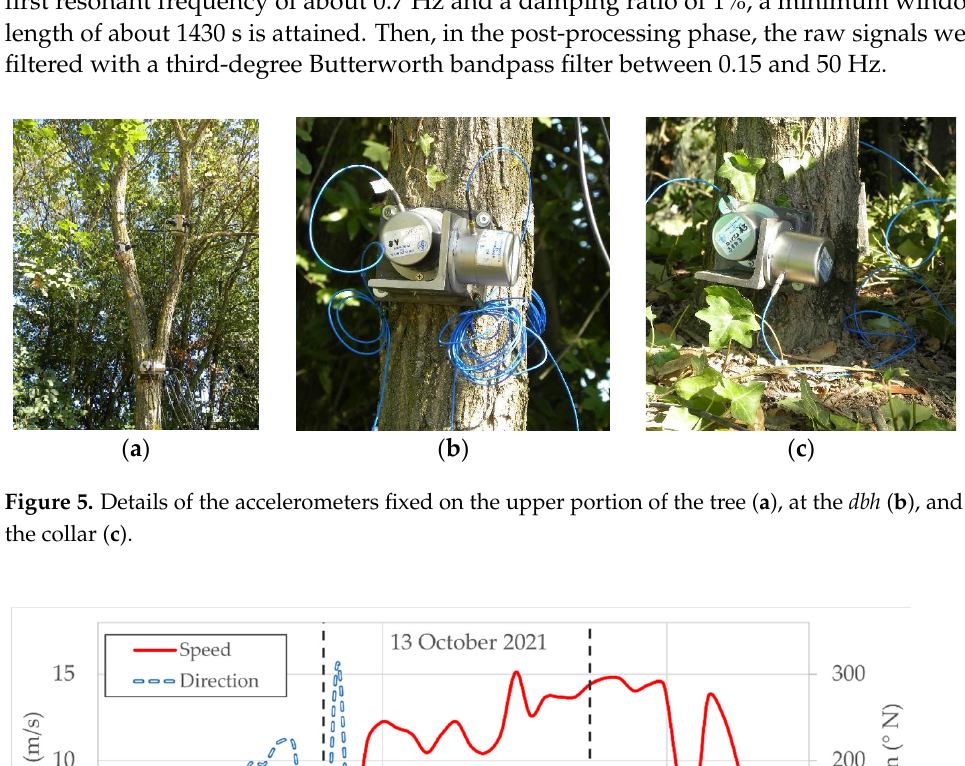
Figure 5. Details of the accelerometers fixed on the upper portion of the tree ( a ), at the dbh ( b ), and at the collar ( c ).